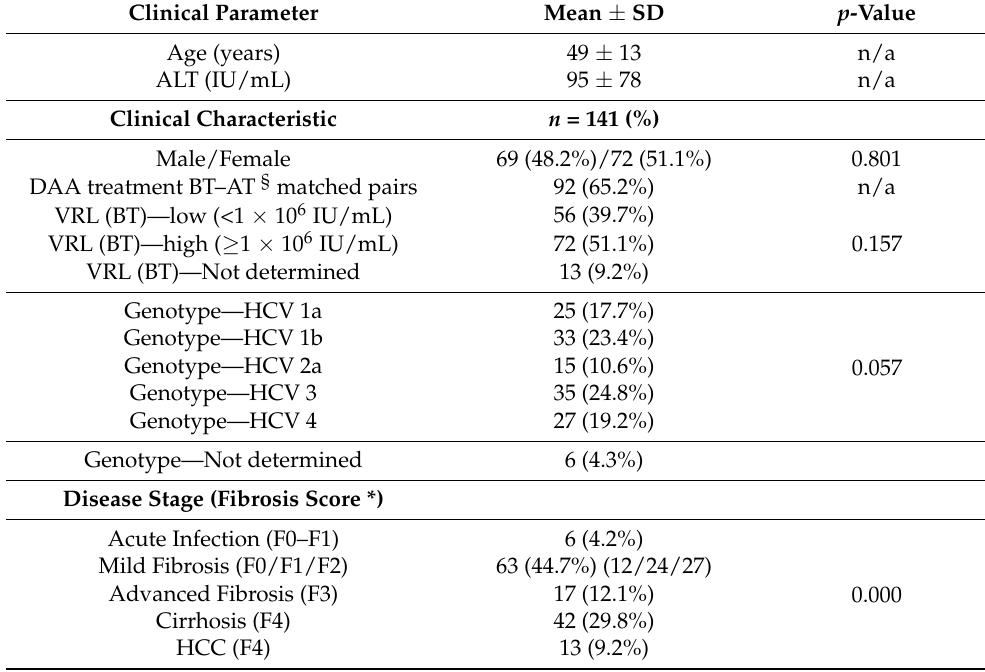
Table 1. Total demographics of the study.